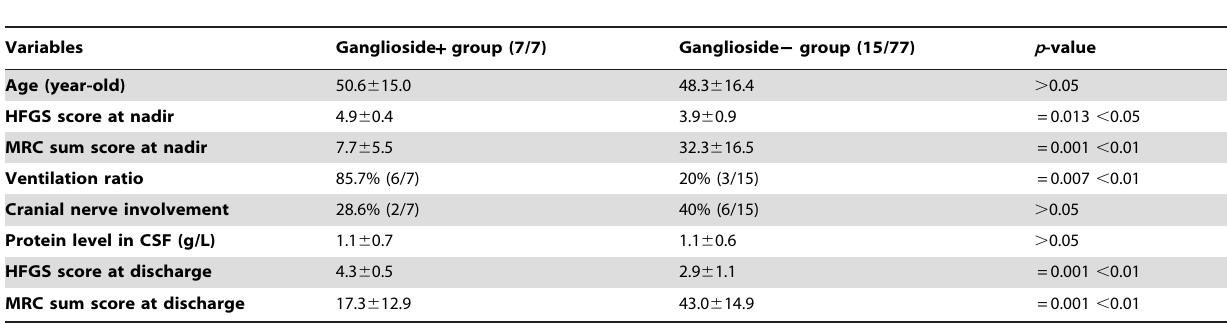
Table 3. Comparisons of clinical features of AMAN patients between the ganglioside + group and the ganglioside 2 group.